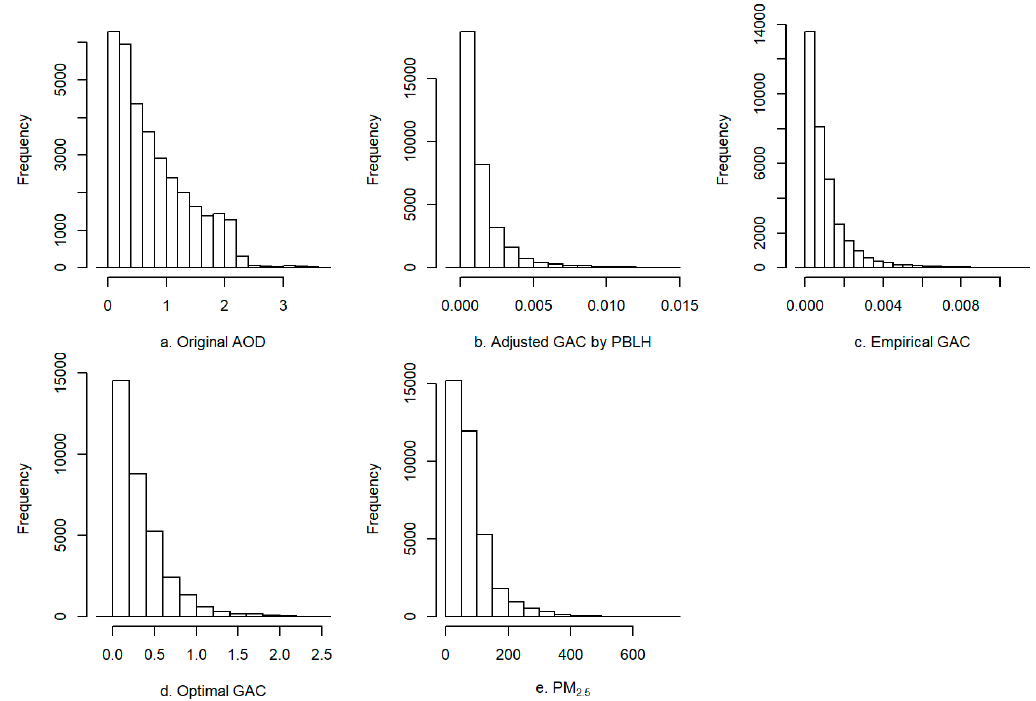
Figure 6. Distributions of satellite AOD, simulated GACs, and PM 2.5 .